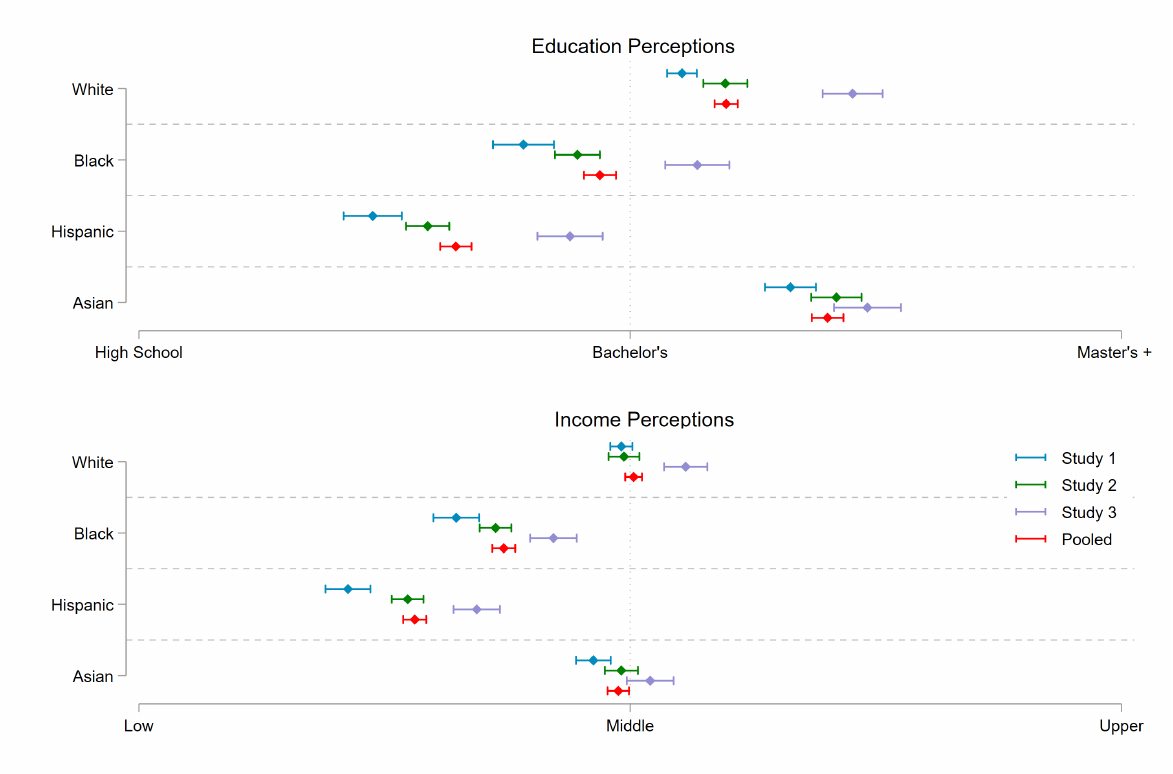
Figure 1: Education and income perceptions by name-signaled race. Note: Data from Studies 1 through 3. This plot shows respondent perceptions of educational attainment and income based on names intended to signal different racial/ethnic categories. Plotted points denote predictions and bars represent 95 percent confidence